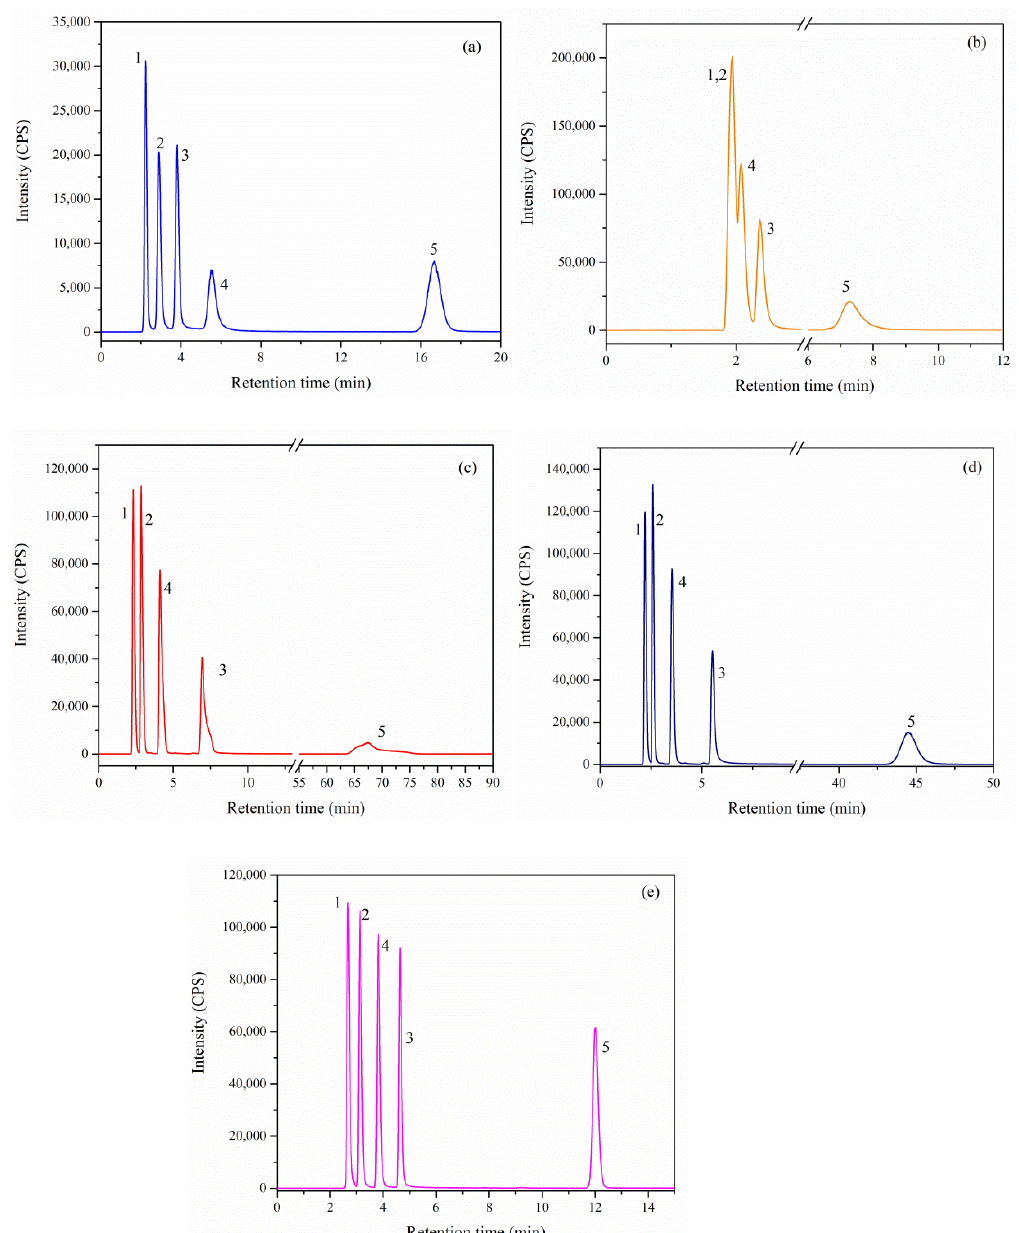
Figure 5. Chromatograms of a mixture of Se species at 500 μg L − 1 (as Se) in solution on anion-exchange column (( a ) Hamilton PRP X-100 (4.1 mm × 250 mm, 10 μm)) and reversed-phase columns (( b ) Agilent Extend C18 (4.6 mm × 250 mm, 5 μm) ); ( c ) Agilent Eclipse XDB C18 (4.6 mm × 250 mm, 5 μm); ( d ) Agilent Eclipse Plus C18 (4.6 mm × 250 mm, 5 μm); ( e ) Agilent SB-Aq (4.6 mm × 250 mm, 5 μm)). The peaks of five Se species in chromatograms were (1) SeCys 2 , (2) MeSeCys, (3) Se(IV), (4) SeMet, and (5) Se(VI).